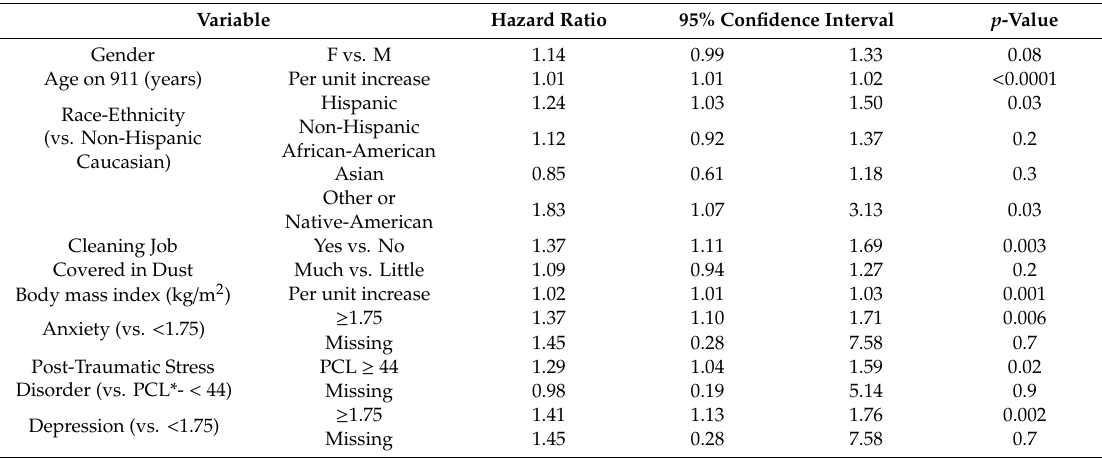
Table 3. Multivariable Cox proportional hazards regression using both Baseline and Return Visit data ( n =